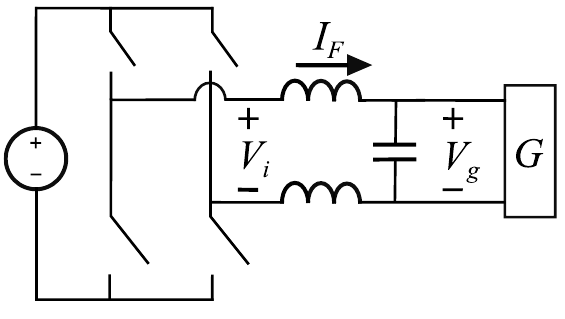
Figure 1. Simple model of a voltage-source converter [20].